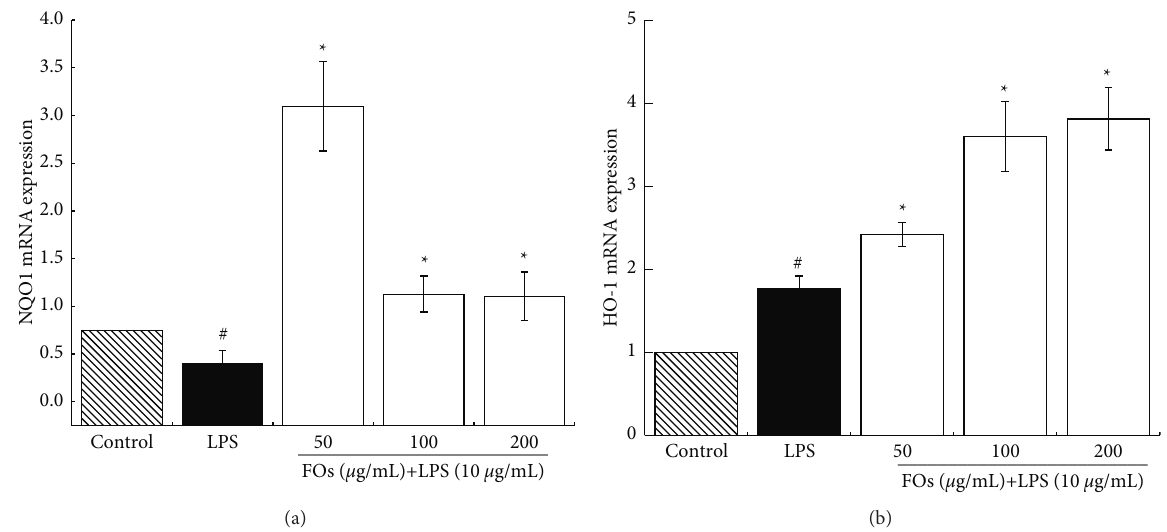
Figure 5: The effects of various concentrations of FOs-FWB on NQO-1 mRNA expression (a) and HO-1 mRNA expression (b) of LPS- stimulated IPEC-J2 cells. The data are expressed as the mean ± SE ( n � 3). # Indicates significant differences from control. ∗ Indicates significant differences from LPS. FOs-FWB: feruloyl oligosaccharides from fermented wheat